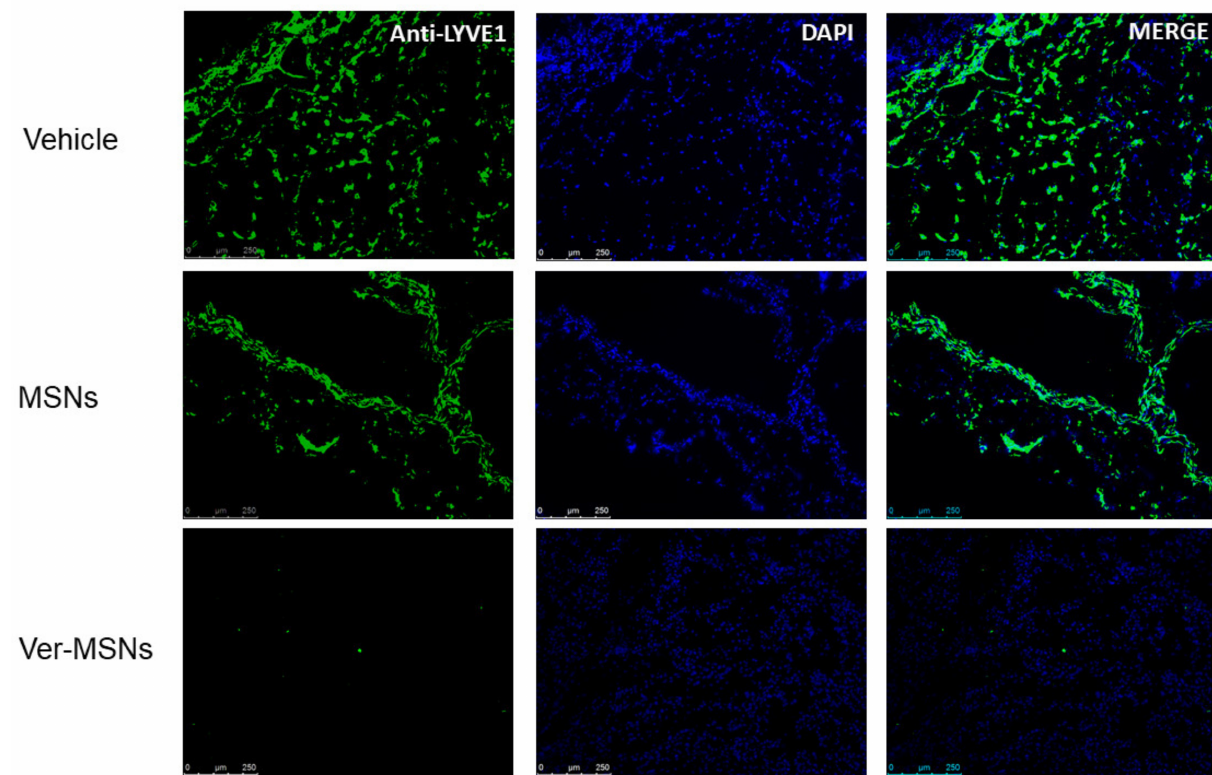
Figure 2. Immunofluorescence anti-LYVE1 on melanoma tumor tissues. Mice with palpable subcutaneous tumors were treated every 4 days with glycerol (Vehicle), MSNs, or Ver-MSNs, with representative images of B16-F10 melanoma stained for LYVE1 (green) and, to view the nucleus, with DAPI (blue). Lymphatic vessels occurring in tumor mass of the vehicle group were reduced by MSN, while treatment with Ver-MSNs was able to abolish the anti-LYVE1 immunofluorescence. Bar = 250 µ